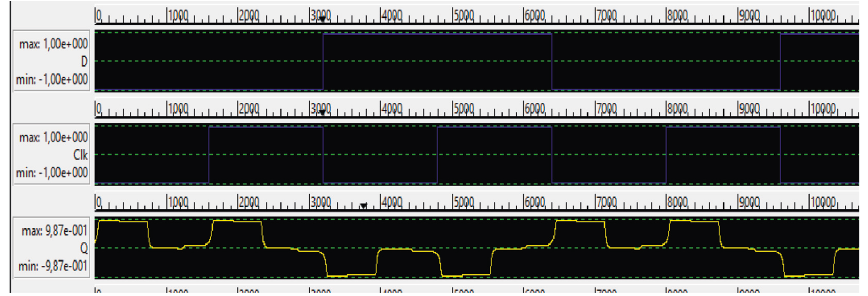
Figure 11: Simulated input-output waveform of the proposed D flip-flop.